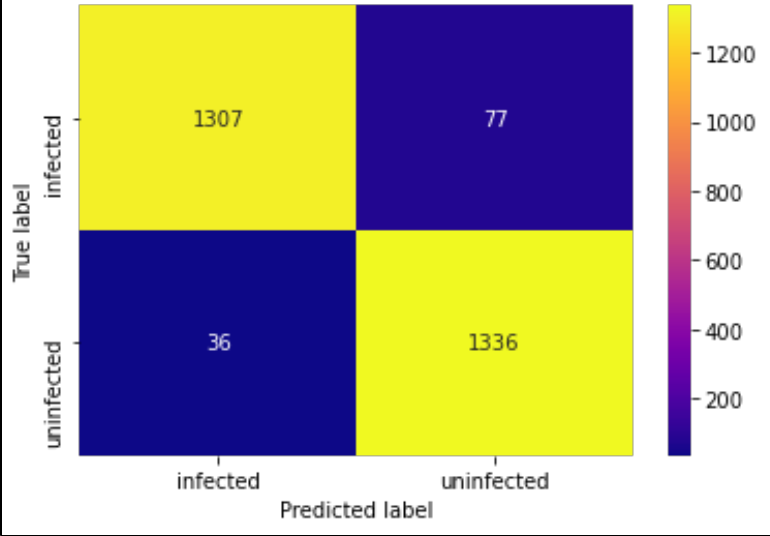
Figure 7. Confusion Matrix of CNN model.